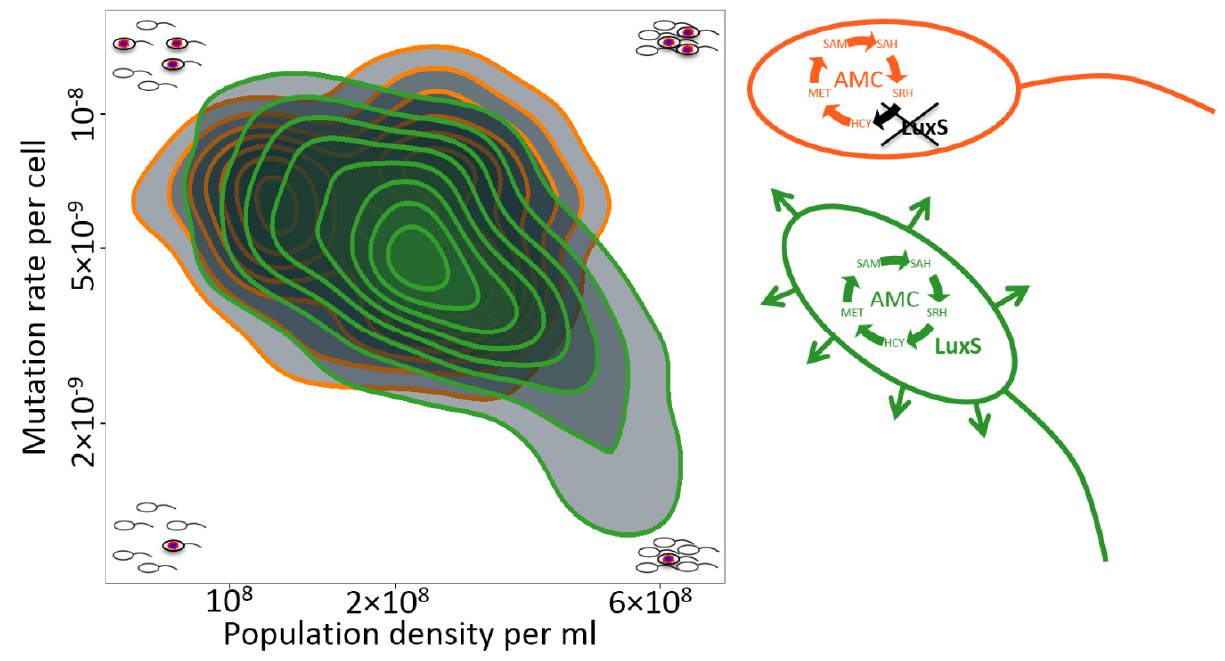
FIGURE 1: Density-dependent mutation rate plasticity in E. coli . The green contours indicate mutation rates for E. coli with a functional Acti- vated Methyl Cycle (AMC; green cell) across a range of population densities. In the example cells in the plot corners, a blue and red explosion indicates a mutational event resulting in a rifampicin resistant cell. The orange contours correspond to luxS deletant cells which don’t pro- duce the signal (arrows coming from the green cell) and have an incomplete AMC (orange cell). Contours are density plots across all the data from Krašovec et al. 2014 (344 data points, 77 of which correspond to the orange contours), including both E. coli B and K12 strains and ac- counting for all the effects noted there (e.g., data from the complemented Δ luxS mutant are included in the green area, not the orange). Abbreviations: HCY, homocysteine; MET, methionine; SAM, S-adenosylmethionine; SAH, S-adenosylhomocysteine; SRH, S-